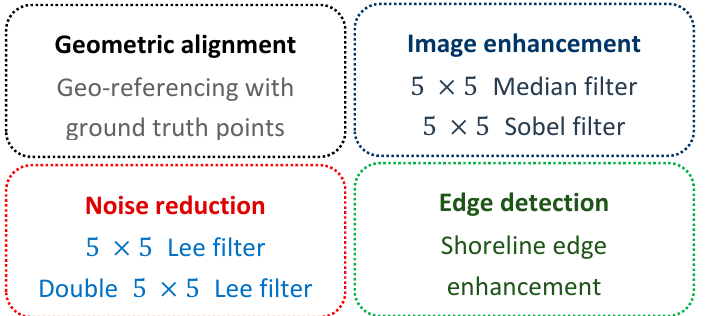
Figure 4. Preprocessing methods applied in this research.